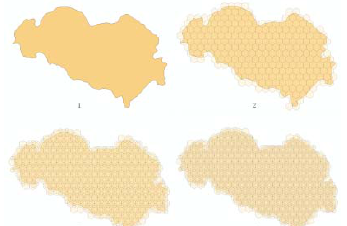
Figure 10. The model construction